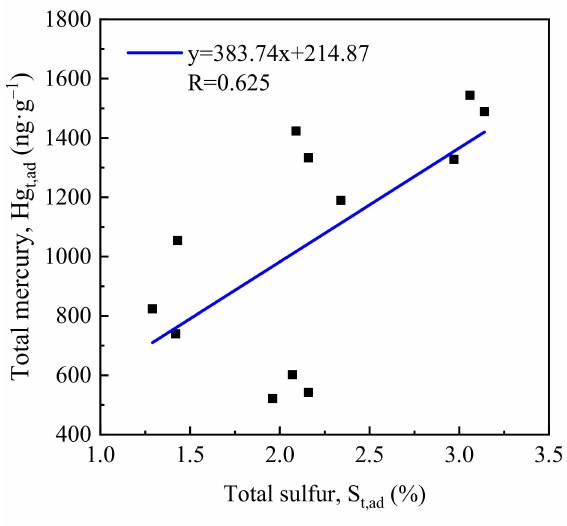
Figure 5. Correlation between Hg and total sulfur in gangue